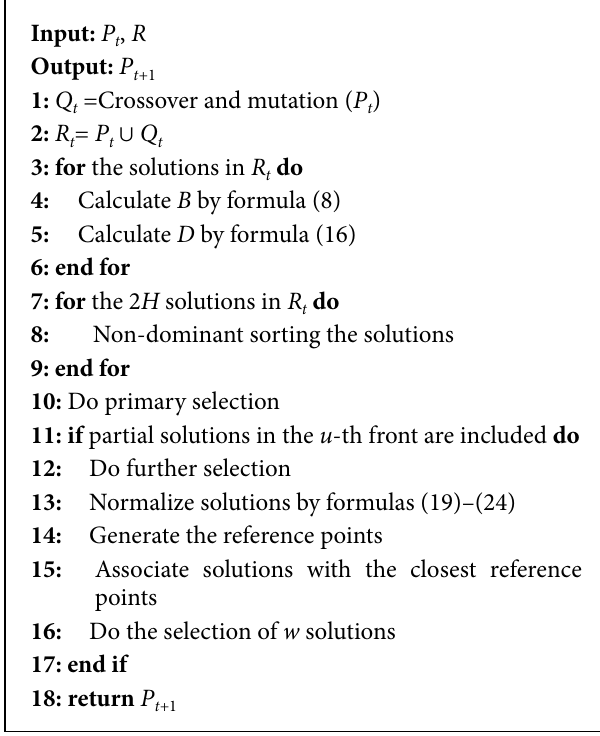
Algorithm 3: Selecting using